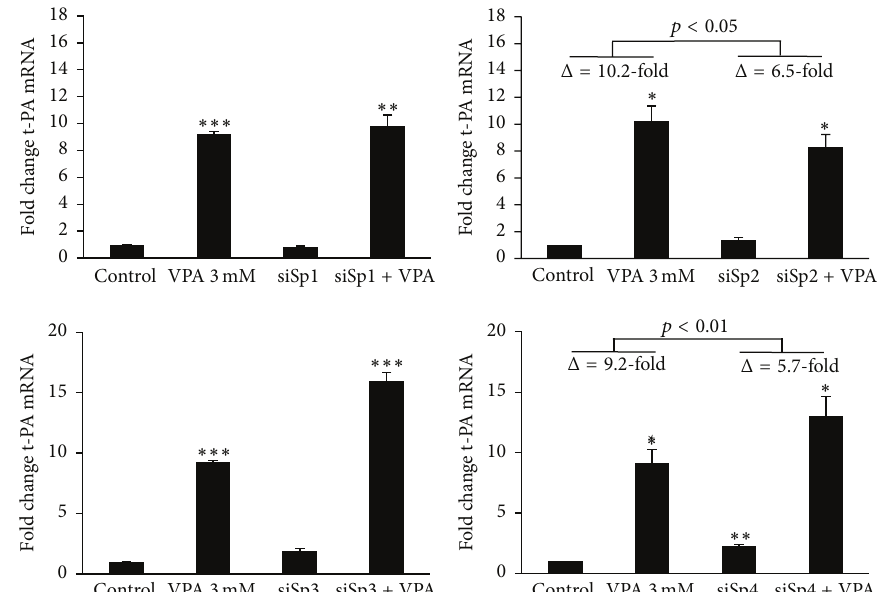
Figure 4: t-PA mRNA expression after siRNA mediated knock-down of Sp factors. HUVECs were treated with siRNA targeting Sp1, Sp2, Sp3, or Sp4 for 72 h and then stimulated with 3mM VPA for 24 h. Statistical comparisons are made relative to untreated control cells. The marks indicate the statistical comparisons of the VPA-induction in nontransfected cells versus the VPA-induction in transfected cells ( Δ = change in t-PA mRNA expression after VPA stimulation). ∗ 𝑝 < 0.05 , ∗∗ 𝑝 < 0.01 , and ∗∗∗ 𝑝 < 0.001 . The results are presented as mean values ± SEM of four independent experiments. The statistical evaluation was performed using paired Student’s 𝑡 -test together with Bonferroni correction for multiple analysis. Not shown in the illustrations are transfection controls with transfection reagent only (mock) and transfection with “All Star Negative” control siRNA (ASN) that were included in each experiment. These negative controls showed no significant effect on either t-PA or target